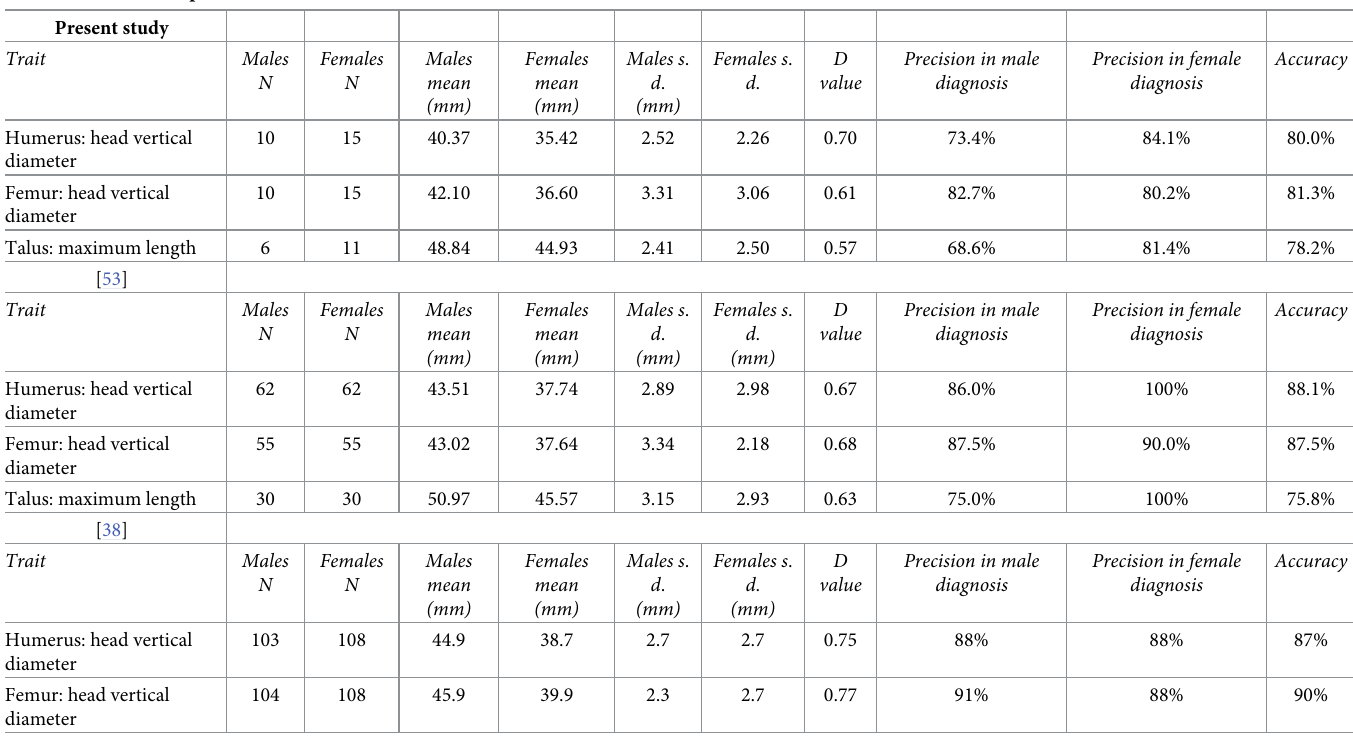
Table 6. Sexual dimorphism and correct sex